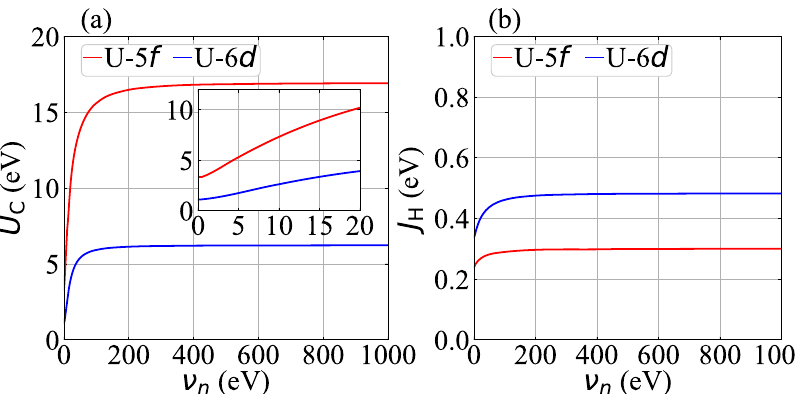
Fig. 1 Calculated on-site Coulomb and exchange interaction. Calculated ( a ) U C for U-5 f and U-6 d , and ( b ) J H for U-5 f and U-6 d in UTe 2 with inclusion of SOC. Insets in ( a ) shows magni fi ed views of U C in low frequency